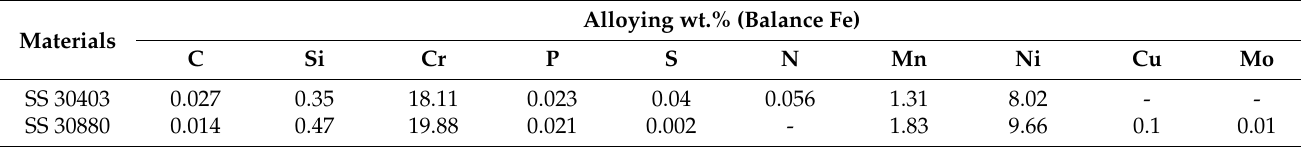
Table 1. Base metal and weld filler metal composition [27]. Alloying wt.% (Balance